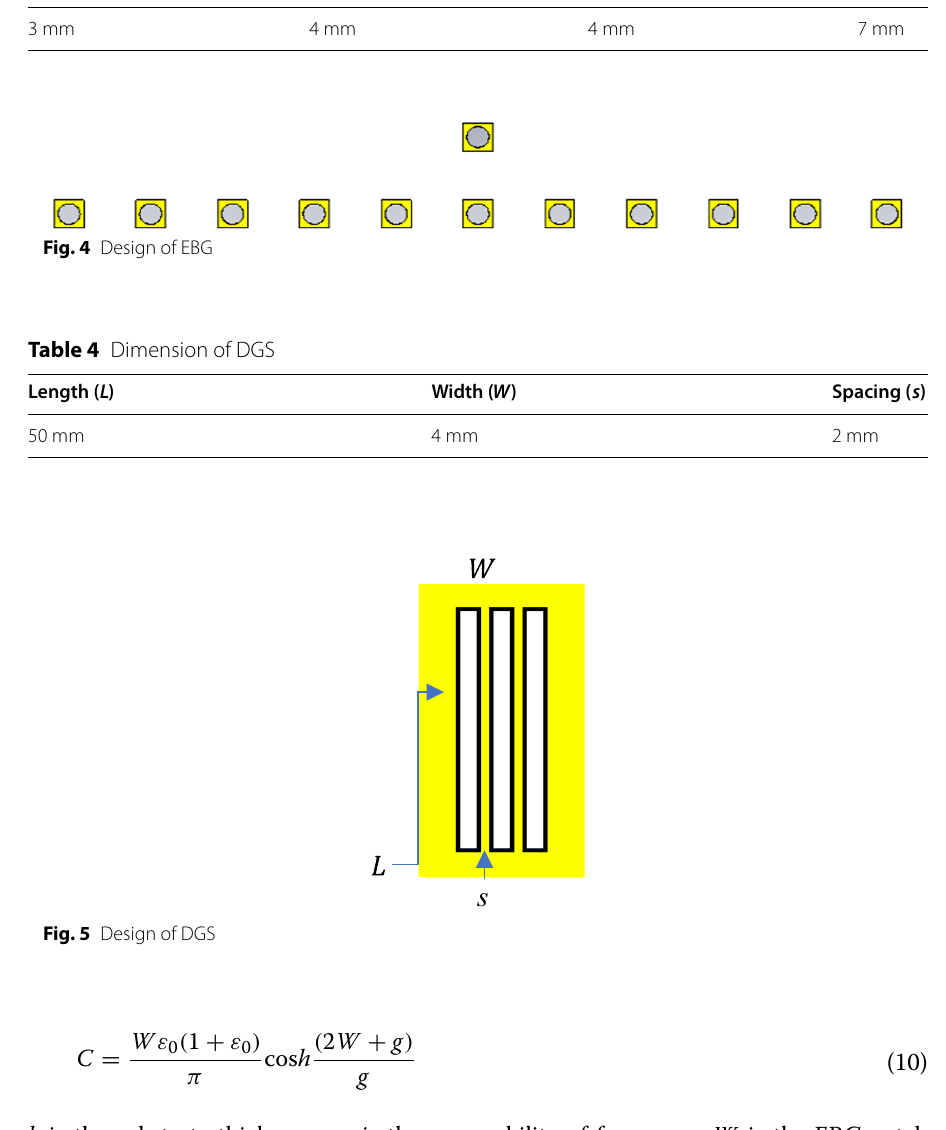
Table 3 Dimension of EBG Dia. Via